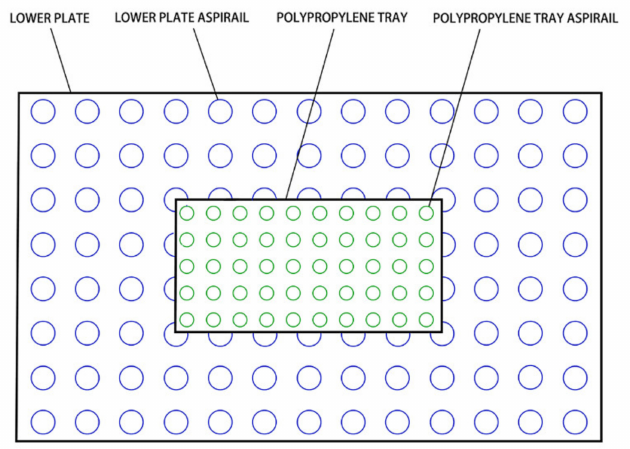
Figure 2. Position of the material